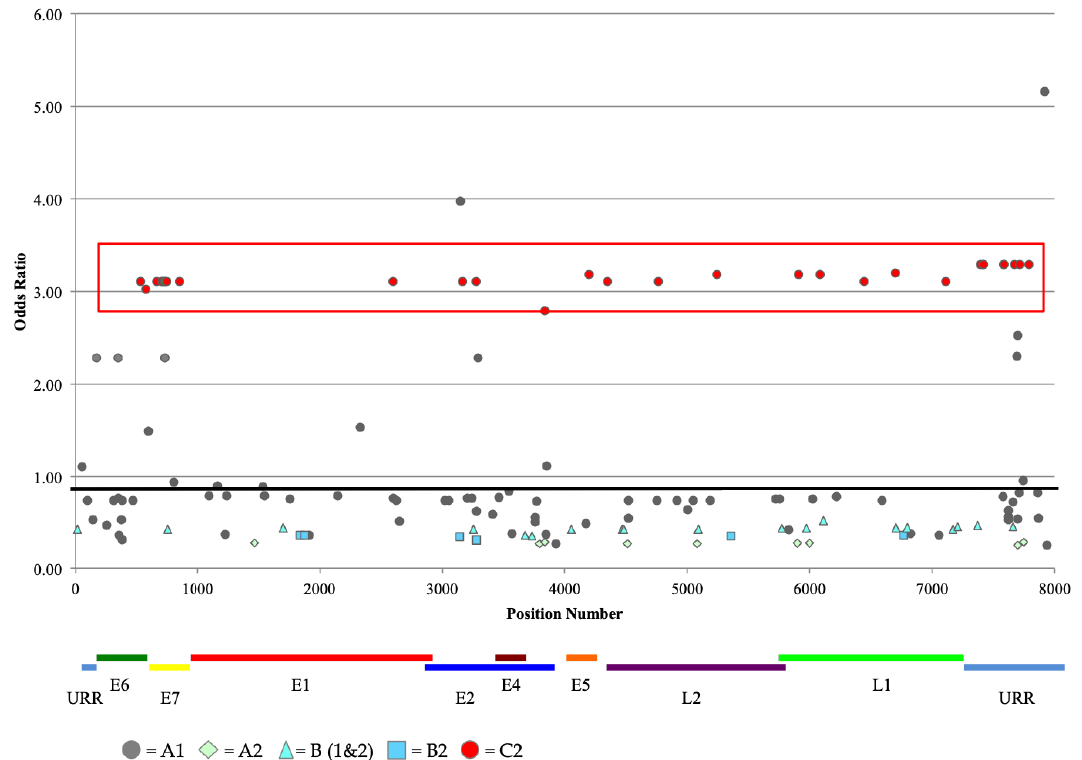
Figure 3. HPV52 viral genome-wide association study. Odds ratios for cases of CIN3 compared to HPV52 control infections were calculated for each SNP that occurred at least twice from the genomic sequence of 87 HPV52s. The red box represents variants associated with the C2 sublineage.